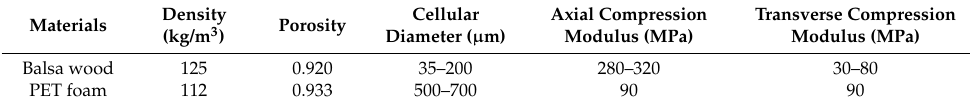
Table 2. The parameters of core materials used in manufacturing sandwich